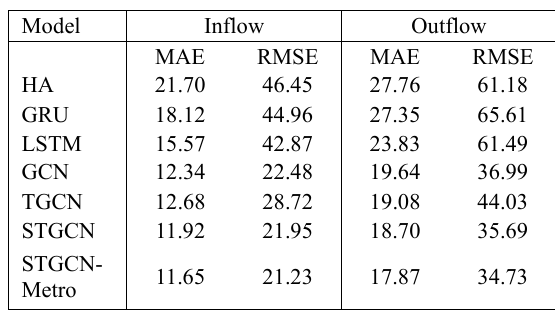
Table 1 . Results comparison of different methods.